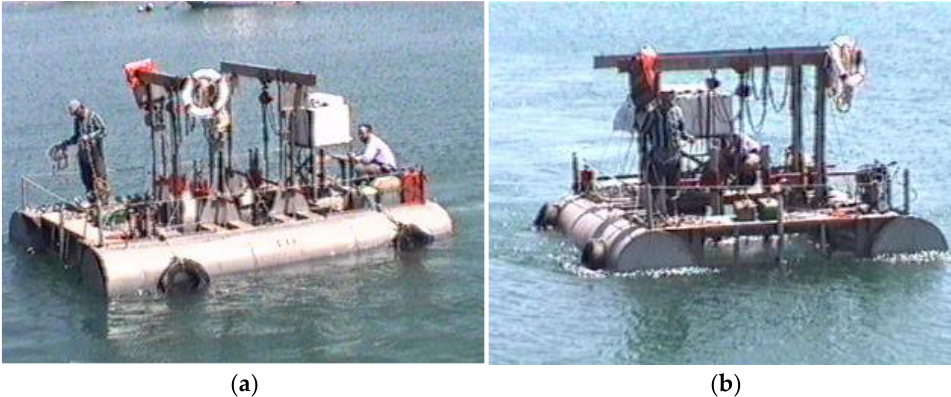
Figure 8. The raft in motion during the testing of scale models D3 ( a ) and D4 ( b ).